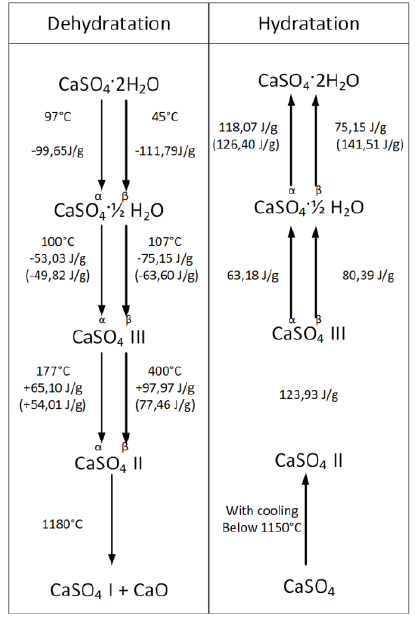
Figure 1. Possible transformations of the dehydration and hydration of synthetic gypsum in the calcination process [23].